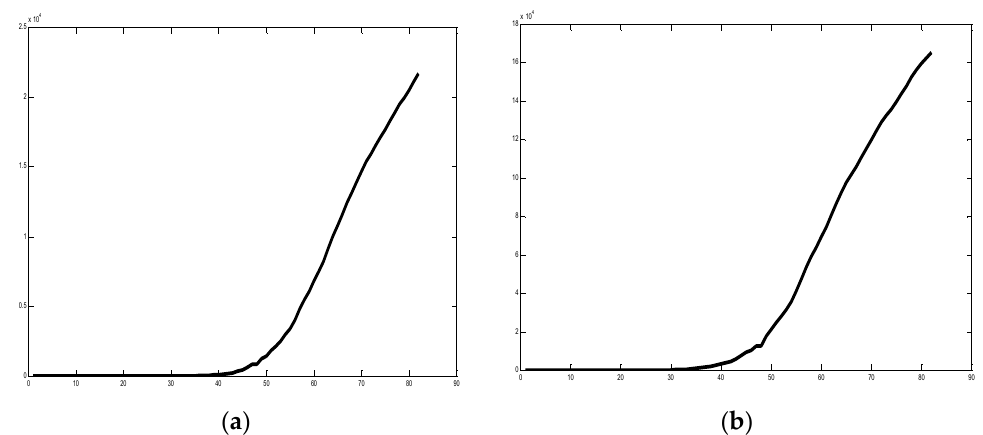
Figure 8. ( a ) Plot of confirmed cases for Italy, ( b ) plot of death cases for Italy (2 January 2020 to 31